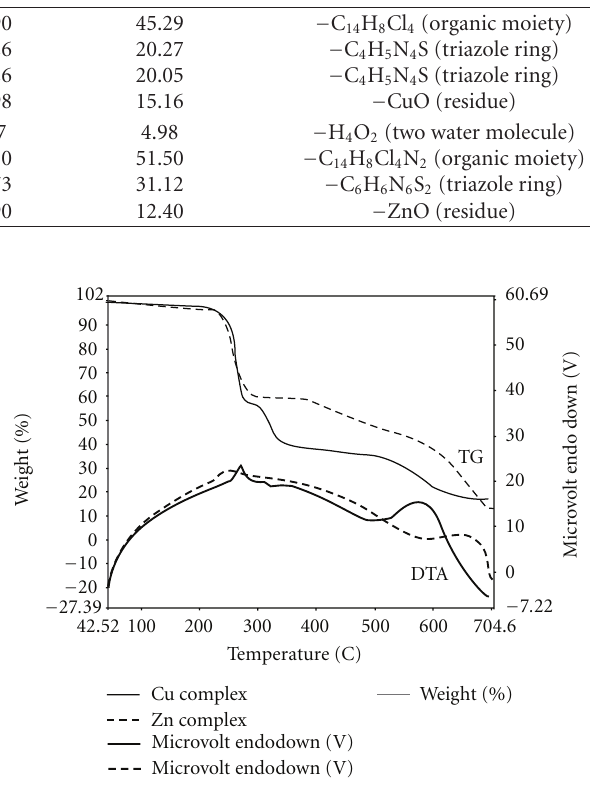
Figure 2: Thermal analyses curve of Zn(L 1 ) 2 · 2H 2 O and Cu(L 2 ) 2 .